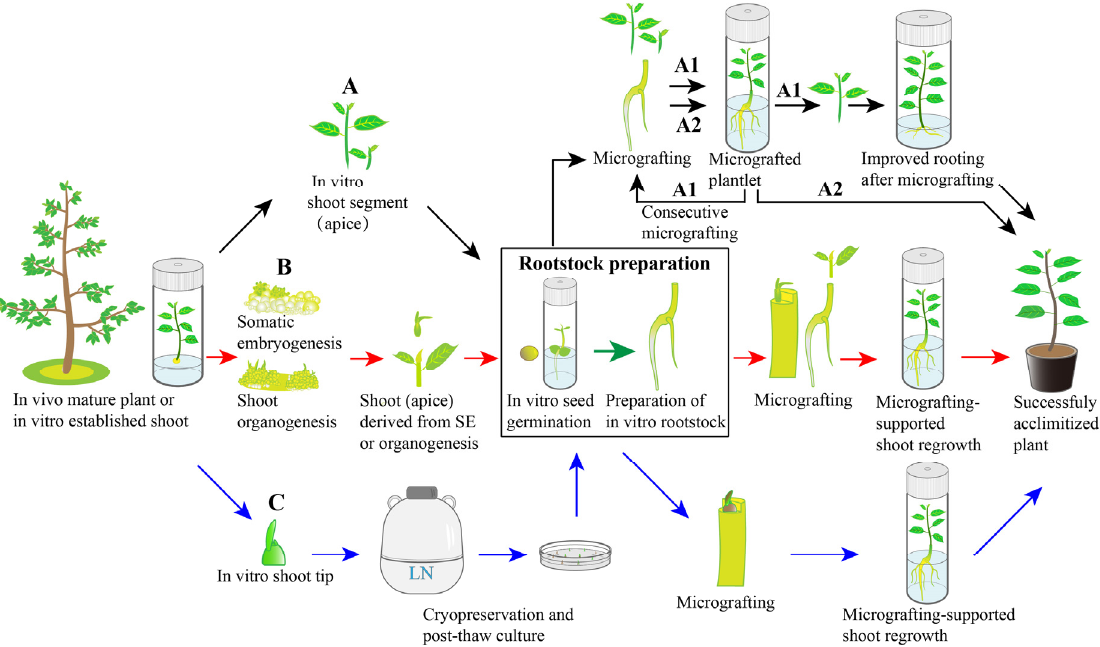
Figure 2. A summary of the applications of in vitro micrografting (IVM) for improved microprop- agation. A (black arrows), the use of IVM for in vitro rooting and reinvigoration. A1 indicates the use of consecutive micrografting for reinvigoration of in vitro adventitious rooting and vegetative growth; A2 illustrates the one-step use of micrografting for in vitro rooting. B (red arrows), the use of IVM to assist in the recovery and regrowth of shoots derived from somatic embryogenesis/shoot organogenesis. C (blue arrows), the use of IVM to support the regrowth of cryopreserved shoot tips. The green arrow indicates rootstock